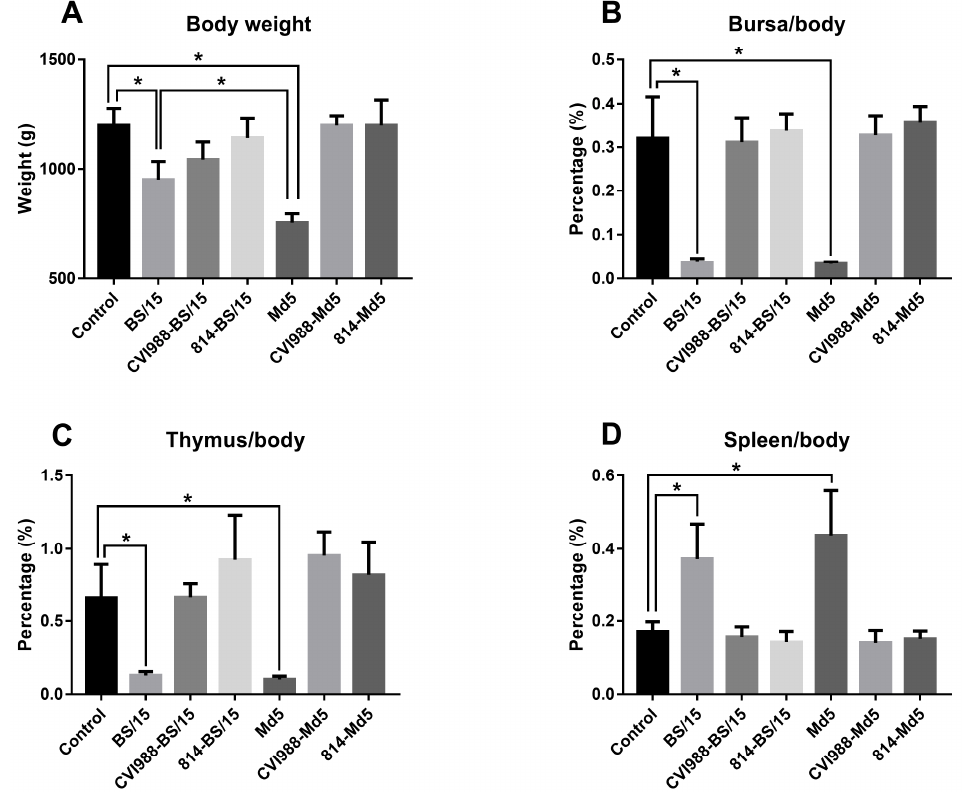
Figure 4. Body weights and ratios of immune organ weight/body weight in the surviving chickens of each group. The data are shown as mean with SD ( n = 2 in the BS/15-challenged group, and n = 3 in the Md5-challenged control group, whereas n = 5 in the other groups), and differences were considered to be statistically significant at p < 0.05 (*). ( A ) Body weights of the surviving chickens in each group; ( B ) Ratios of bursa weight/body weight in the surviving chickens of each group; ( C ) Ratios of thymus weight/body weight in the surviving chickens of each group; ( D ) Ratios of spleen weight/body weight in the surviving chickens of each group.